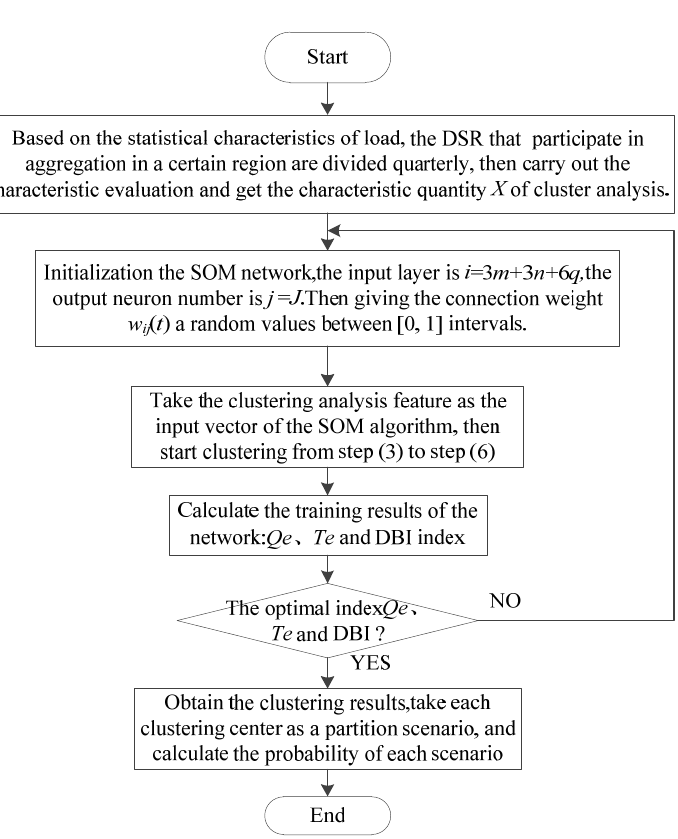
Figure 5. The flow chart of DSR multiple scenarios building based on quarterly division and SOM algorithm.